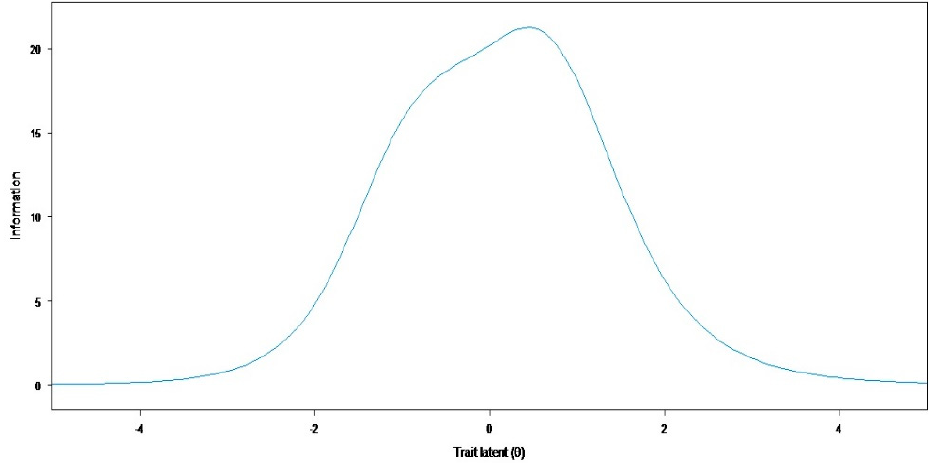
Figure 1. Test information.